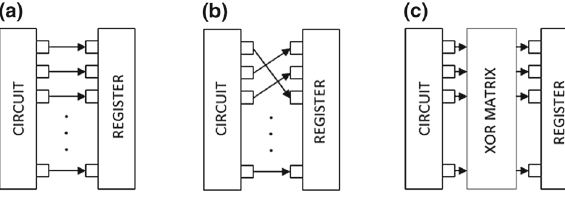
Fig.6 Circuitoutputstoregisterinputsconnectiontype a outputmatrix E, b output matrix 1, c output matrix